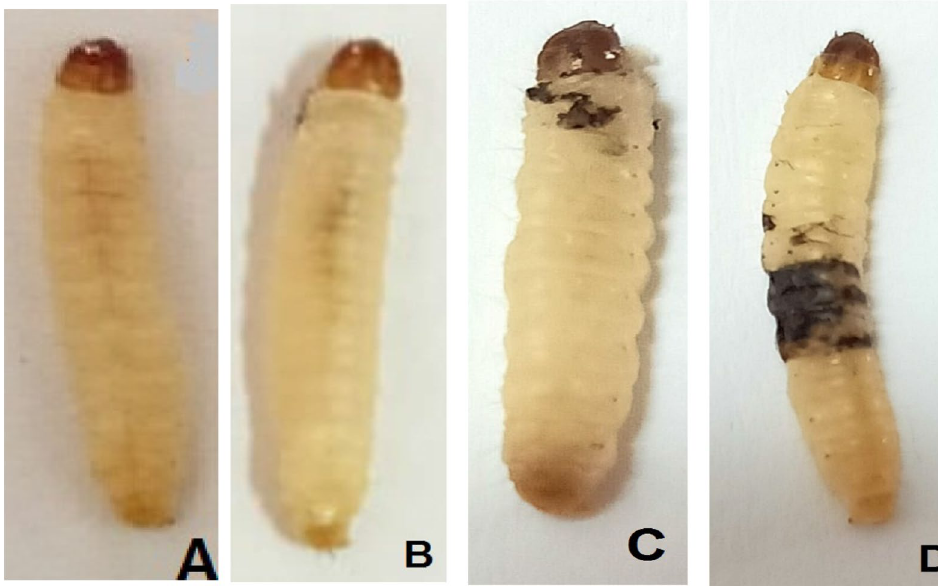
Fig. 2 Photomicrograph showing changes in the color patterns of Corcyra cephalonica larvae A normal larva; B 24; C 48 and D 72 h after